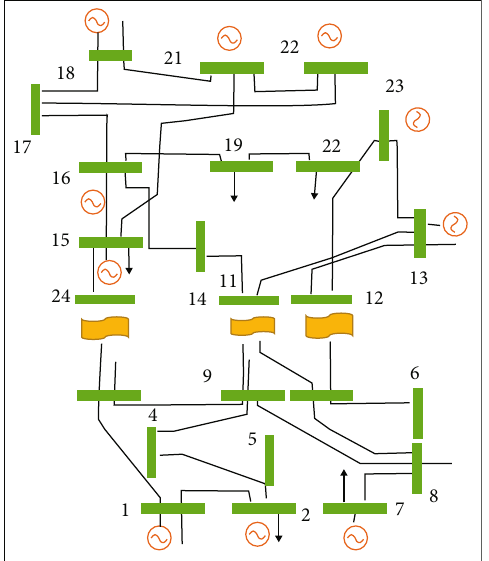
Figure 5: IEEE 24 node test